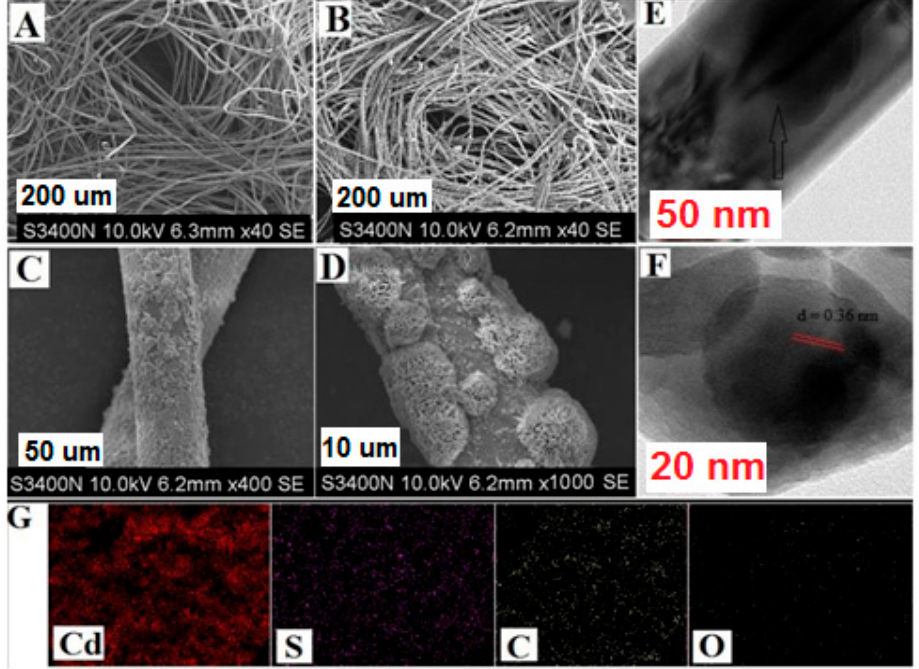
Figure 1. Field emission scanning electron microscope (FESEM) image of: ( A ) nascent cellulose nanofibrils (CNFs); ( B – D ) cadmium-sulfide-decorated cellulose nanofibrils (CNFs@CdS) at varying magnifications; ( E , F ) high resolution tunneling electron microscopy (HRTEM) images of CNFs@CdS;